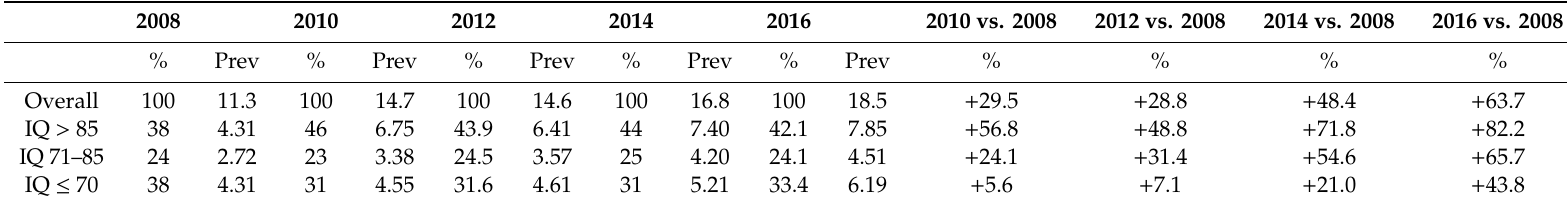
Table 7. CDC-ADDM Network ASD prevalence estimates per 1000 children of 8 years of age, in the overall group and in IQ subgroups, from 2008 to 2016 in USA,